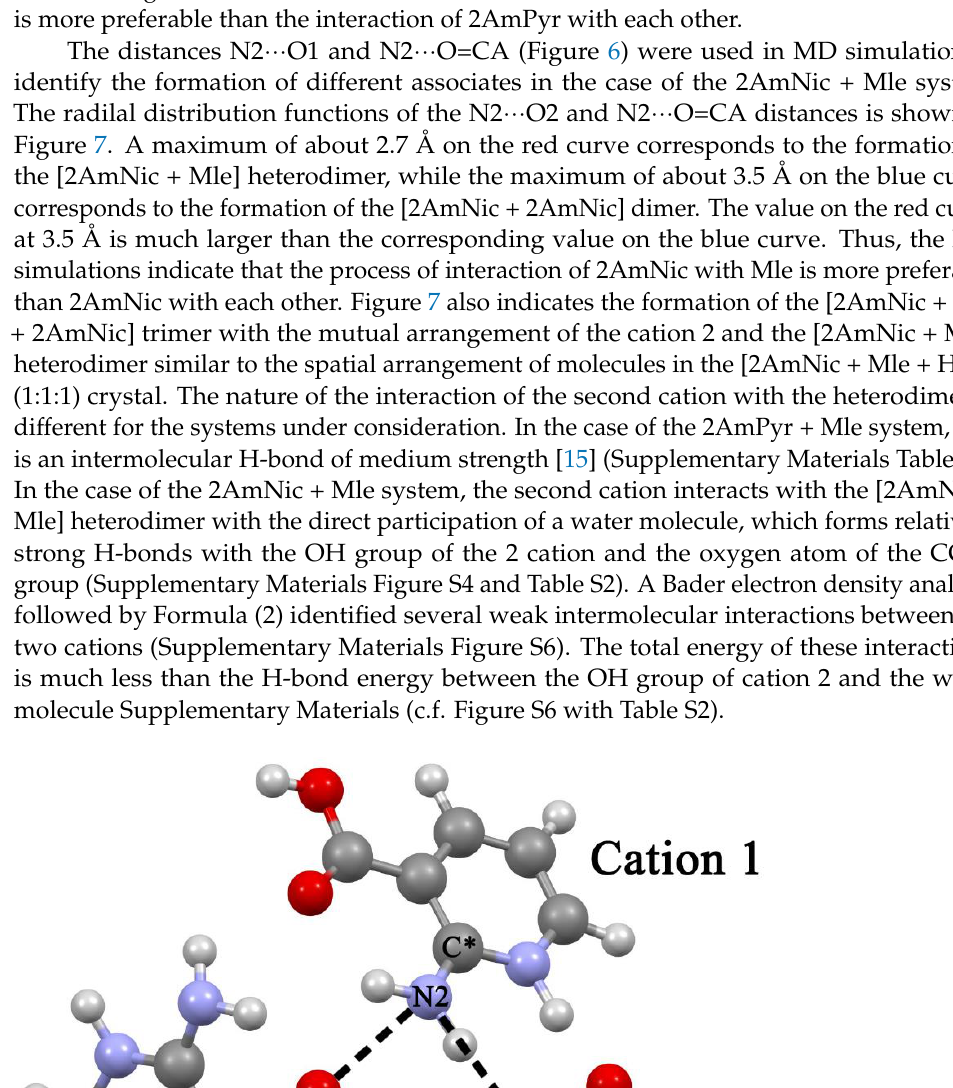
Figure 7. The radial distribution function of the R[N2 ··· O2] (red) and R[N2 ··· O=CA] (blue) distances obtained from the 100 ns NPT simulations. An essential feature of trimers is that the oxygen atoms of the CO 2 − group of the maleic acid monoanion form four H-bonds, three of which are intermolecular. The total en- thalpy/energy of intermolecular H-bonds is more than 70 kJ/mol (Supplementary Materi- als Table S2). That is, the association process proceeds through the formation of three in- termolecular H-bonds by the CO 2 − group of the maleic acid monoanion in both systems. The results obtained indicate a key role of the maleic acid monoanion in association pro- cesses in aqueous solution, since the formation of its heterodimers with APIs is more pref- erable than the formation of API dimers.